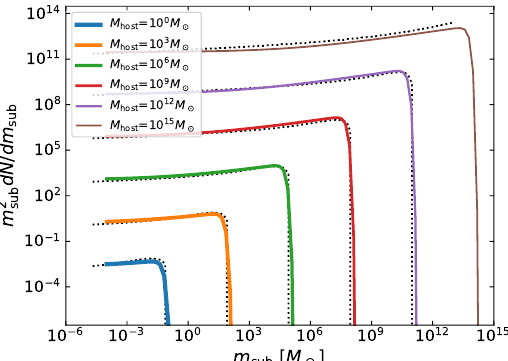
Figure A1. Subhalo mass function m 2 dN / dm at z = 0. Each line corresponds to a different host halo mass. The fitting formula is applicable for the host mass from M host up to 6. ∼